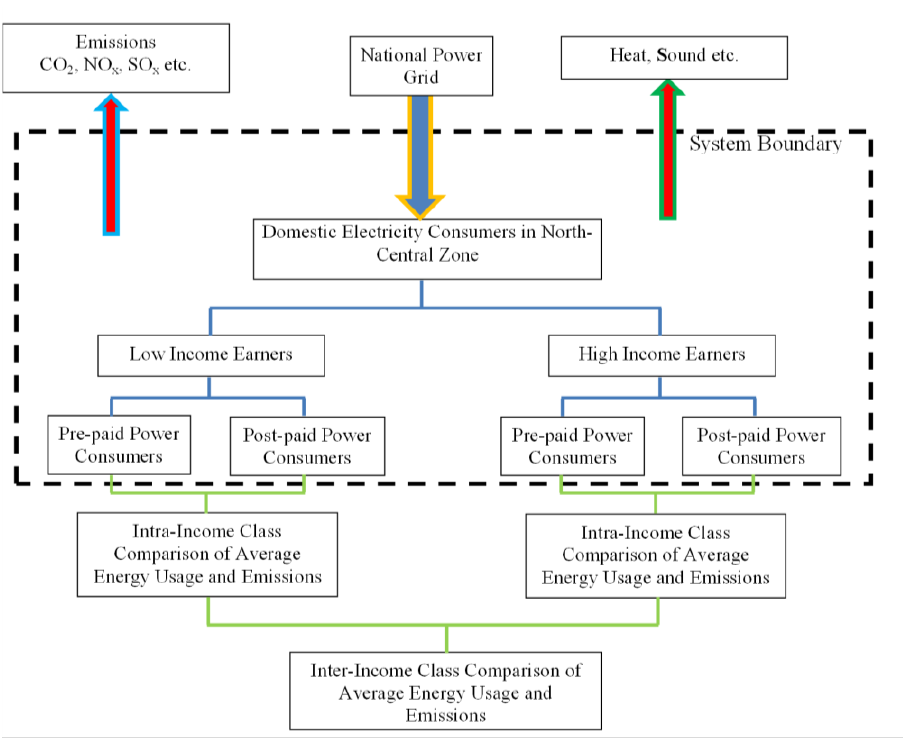
Fig. 1. Gate-to-Gate LCA of domestic energy consumption in North-central